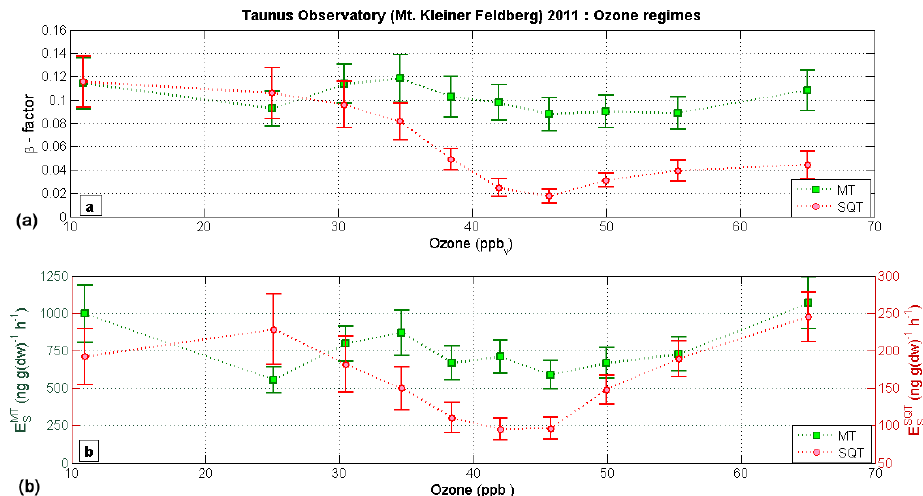
Fig. 5. β -factor (upper plot) and emission potential E s ,T (lower plot) for MT (green squares) and SQT (red cycles), derived from regression analysis for ten individual ozone regimes with the same probability. β MT and emission potential ( E s,MT ) were almost constant along the complete ozone spectrum with no significant variation is visible. On contrary, β SQT display smaller values after the fourth ozone regime. The respective emission potential ( E s,SQT ) is displayed as a dynamical well along the ozone spectrum, with the lowest values to be observed for the range with the most representative ozone concentrations for the